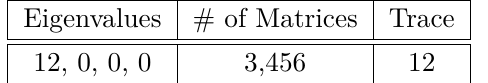
Table 27 . Eigenvalue equivalent classes of 3,456 distance matrices in class (2.3).